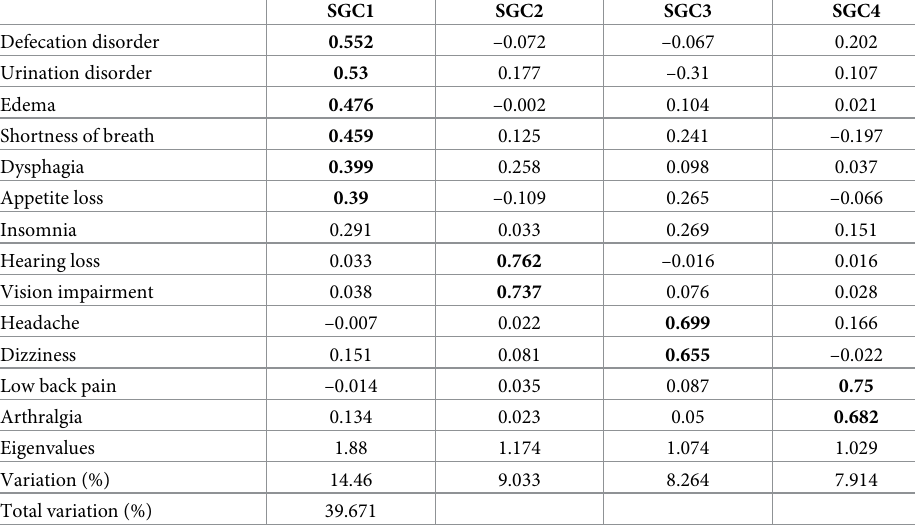
Table 3. Categorical principal component analysis (CATPCA) yielded four components.